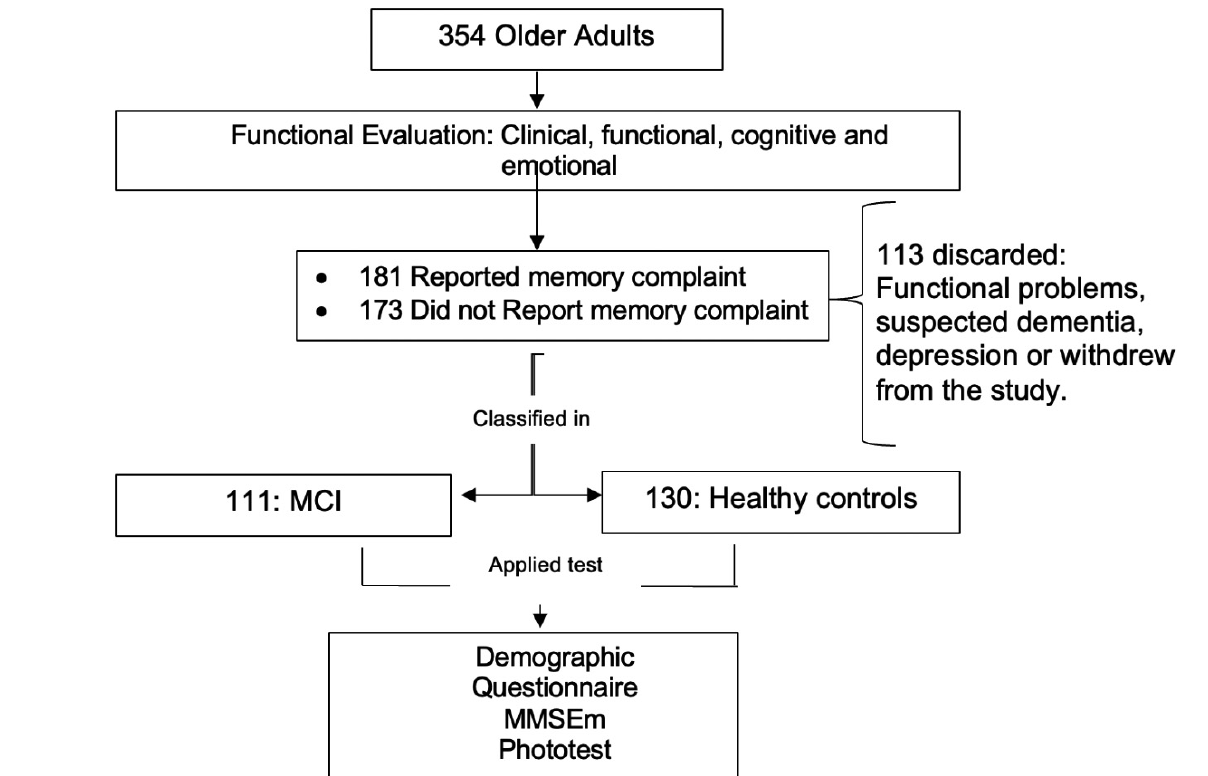
Figure 1. Study flow